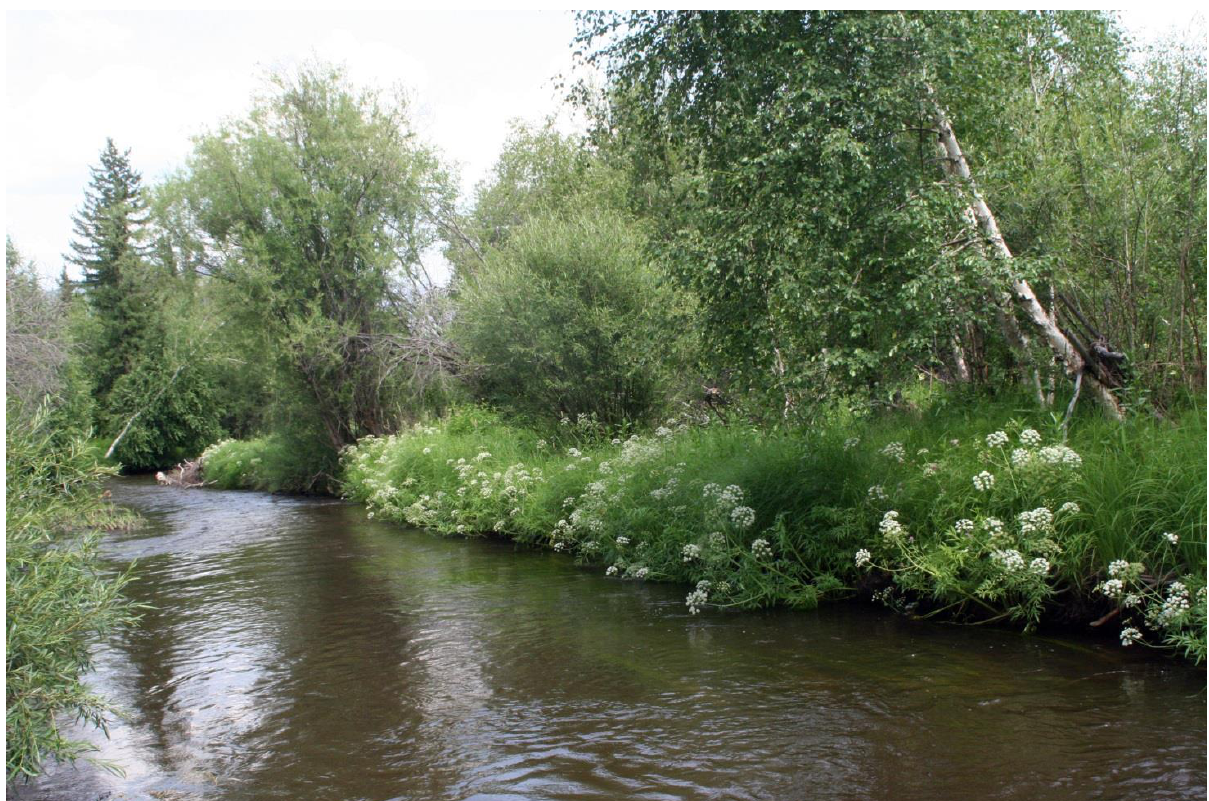
Fig. 2. Uyuk River. Piy-Khem Kozhuun, 30 June